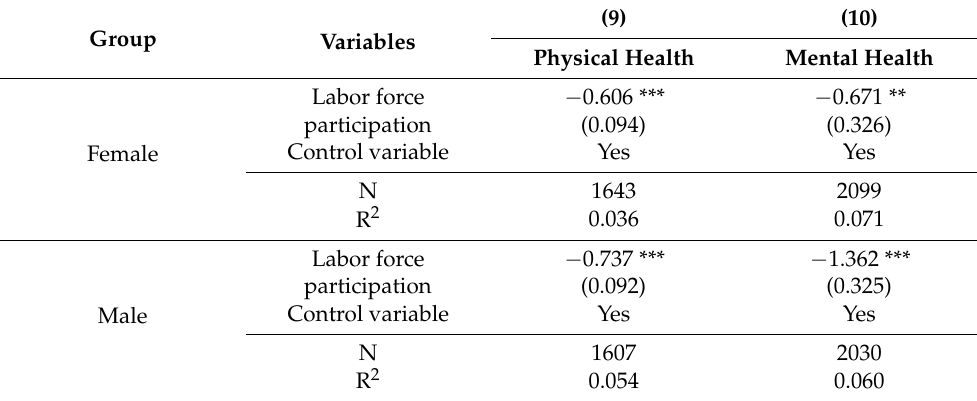
Table 7. Differences in the effect of gender on the health status of older adults.